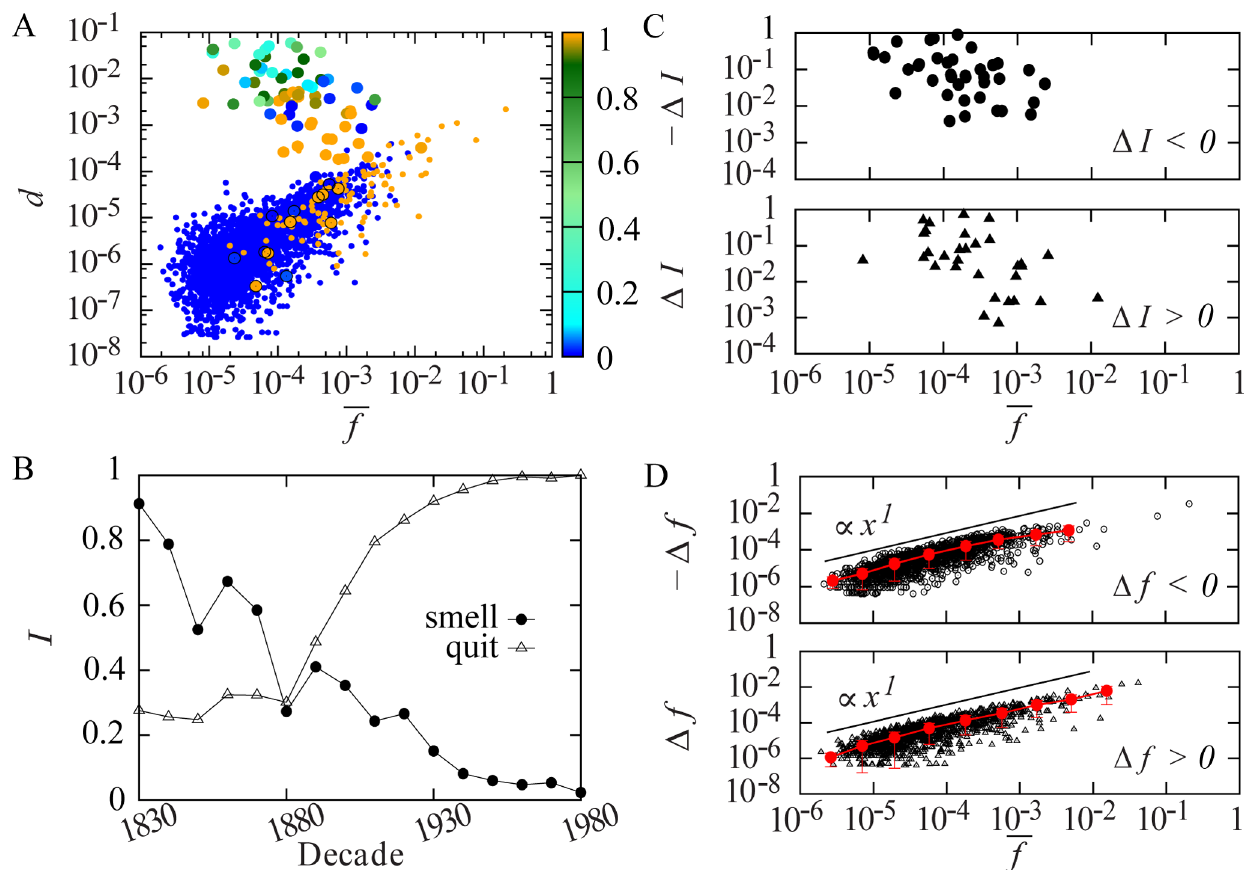
Figure 3. Excursions in frequency and proportion of irregularity in the core vocabulary. (A) Plot of d against (cid:2) ff (frequency averaged across all the decades) for core roots. Points are color-coded according to their average I across all the decades. Active roots are represented by larger points, patterning predominantly in the upper ‘‘cloud,’’ distinctly away from stable regular and irregular roots. Some active roots fall into the lower ‘‘cloud’’ (indicated by black circles), due to an effective net D I ~ 0 (i.e., I fluctuates below 1 or above 0 between the first and last decade, but has the same value in the first and last decade). (B) Plot of the time evolution of I for exemplars of irregularization ( quit ) and regularization ( smell ). (C) Excursion in irregularity proportion D I ( { D I when negative) calculated as the difference in I between the first and last decade plotted against (cid:2) ff for the 69 active roots with a non-zero D I between the first and last occurrences. A negative D I indicates regularization, a positive D I indicates irregularization. The decreasing trend with increasing average frequency corresponds to the behaviour of the ‘‘cloud’’ in (A). (D) Excursion in frequency D f ( { D f when negative) against (cid:2) ff for all core roots. Red points represents binning of (cid:2) ff and D f , error bars are given for D f . The trend of D D f D proportional to (cid:2) ff is